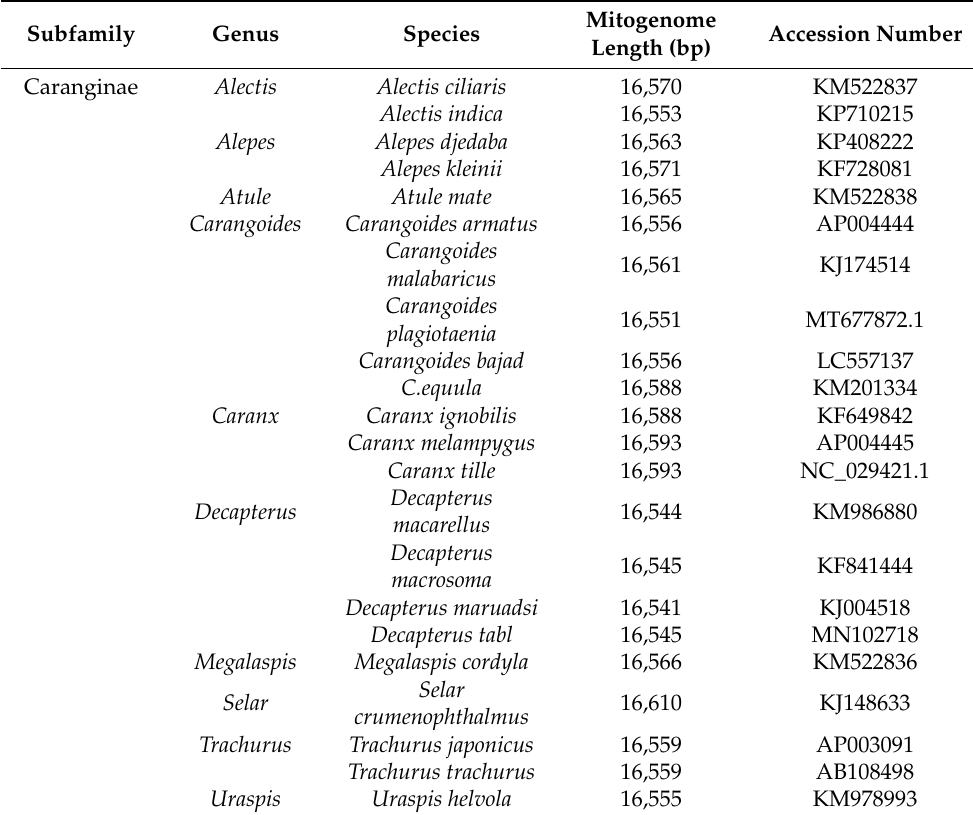
Table 1. Taxonomic information and GenBank accession numbers of all species cited in the mi- togenome PCGs phylogenetic